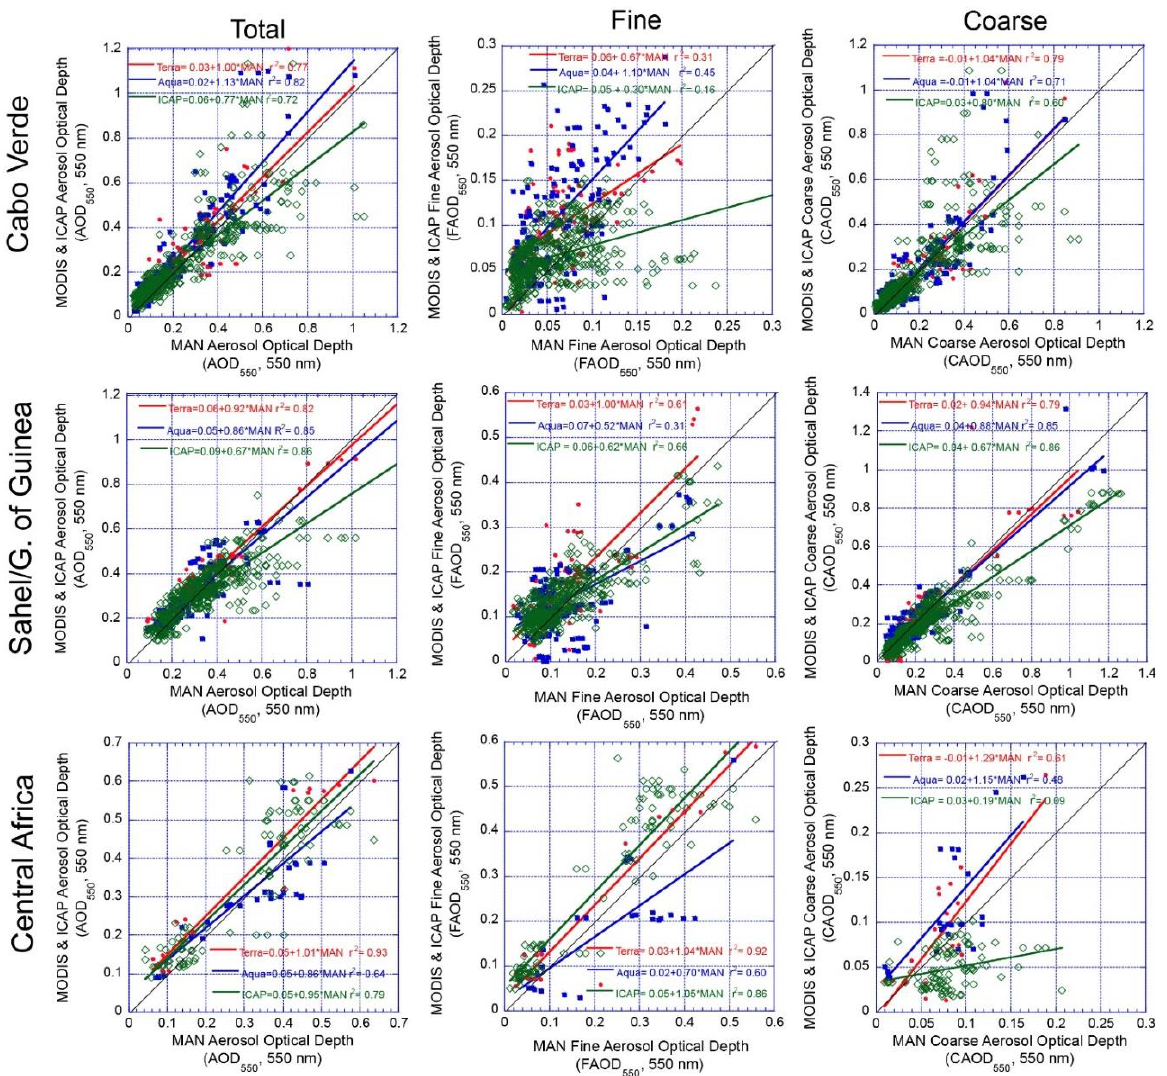
Figure 13. Scatter plots of total AOD (AOD 550 ), fine mode AOD (FAOD 550 ), and coarse mode AOD (CAOD 550 ) for three regions of the Atlantic off Africa. In these plots, we provide regressions of (upper row) the dust-dominated Saharan dust plumes (30° – 15°N; 15° – 35°W) centered around Cabo Verde transitioning into (middle row) mixed dust, biomass burning, and pollution sector, then into a Sahel/Gulf of Guinea sector (~15°N to the equator; 25°W to 1°E), and eventually into (lower row) biomass burning dominated central Africa (~equator to 15°S; 5°W – 15°E). Table 6. Diagnostic error mean bias+root mean square deviation (RMSD) for Terra and Aqua MODIS and the C4C consensus for three AERONET sites representing the west coast of Africa. Left columns, Cabo Verde sampling the Saharan dust plume dominated (16.7°N, 22.9°W); middle columns, Sao Tome representing the Sahel and Gulf of Guinea with a mixture of mixed dust, biomass burning and pollution (0.4°N, 6.7°E); and right columns, St. Helena, dominated central Africa (~15.9°S, 5.7°W). The AERONET observation means + standard deviations are also shown.